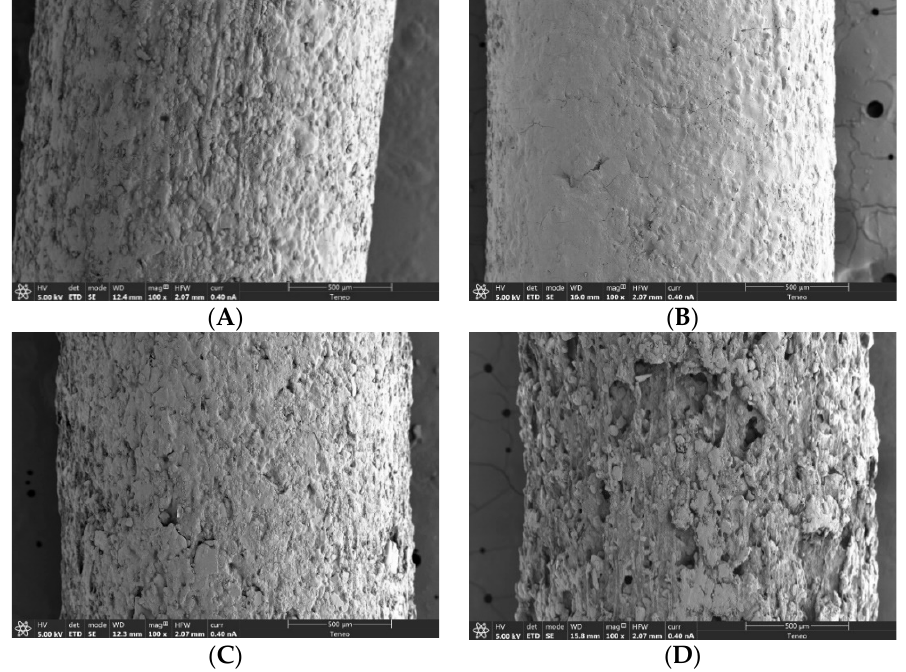
Figure 4. SEM images, magnification 100X, of drug-loaded filaments made with blends containing 7.5% of both MS and PEG 6000: ( A ) 20B; ( B ) 30B; ( C ) 40B; ( D ) 50B.